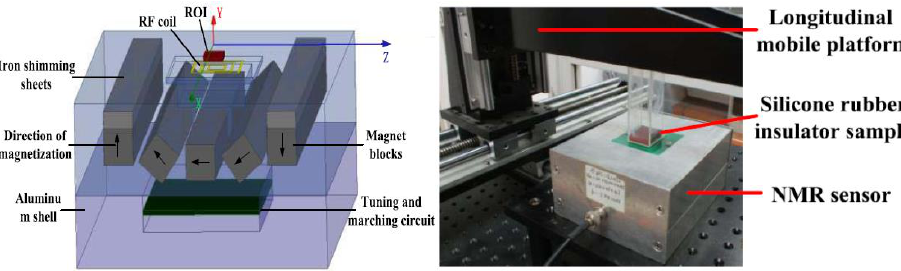
Figure 7. Miniaturized NMR MOUSE sensor.